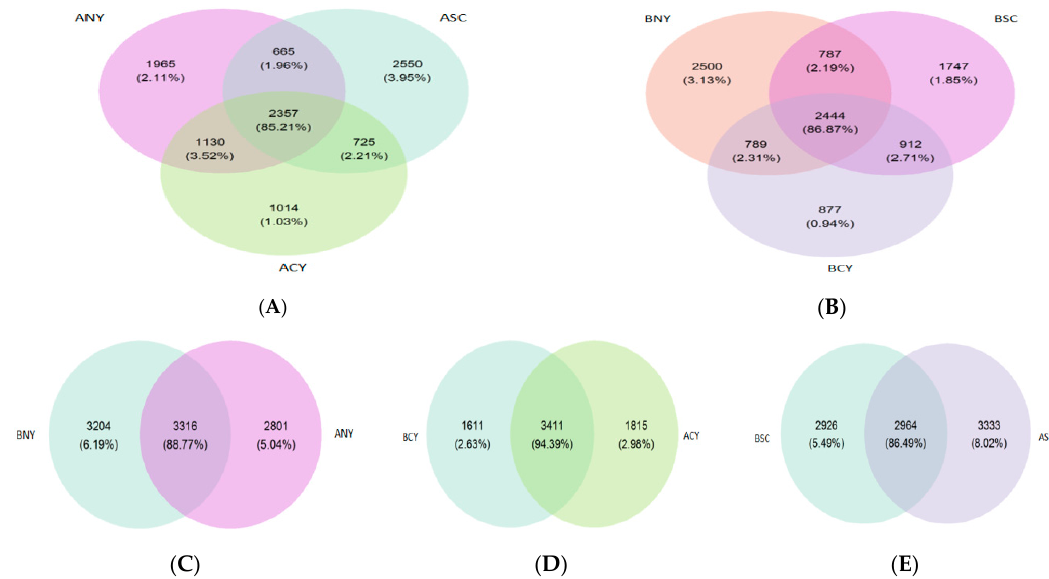
Figure 2. Venn diagram representation of the shared and exclusive OTUs at the 97% similarity level among the three parts of the rumen bacterial community before ( A ) and after ( B ) transportation in NY, SC, and CY groups: between BNY and ANY ( C ), BCY and ACY ( D ) and BSC and ASC ( E ). Microbiota Composition of Rumen